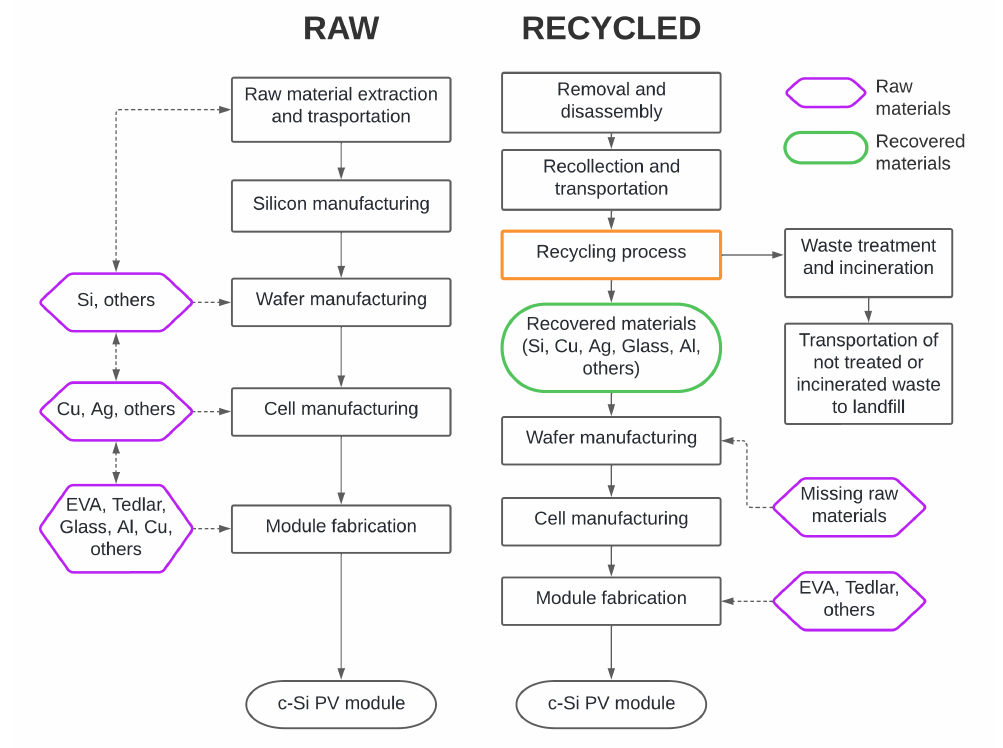
Figure 4. PV manufacturing comparison model. The ”Raw” approach shows the manufacturing of PV modules starting from raw materials. The ”Recycled” approach shows the manufacturing of PV modules using materials recovered from the recycling process considered for this study and the other raw materials